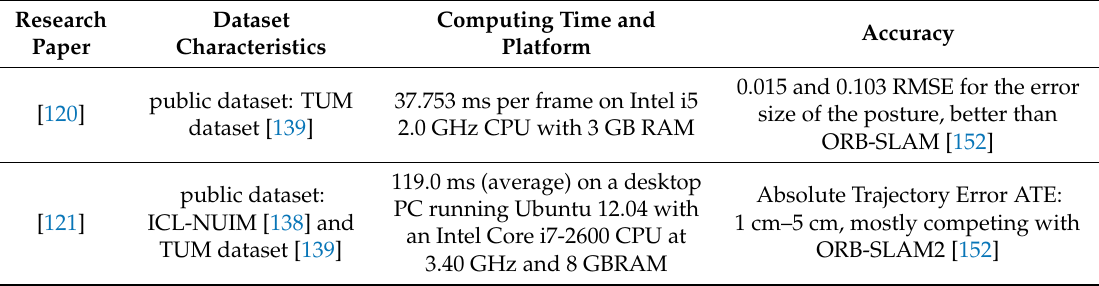
Table 17. Characteristics of indoor localization solutions with an existing/generated 3D model of the environment, 3D mobile cameras, real features, and artificial